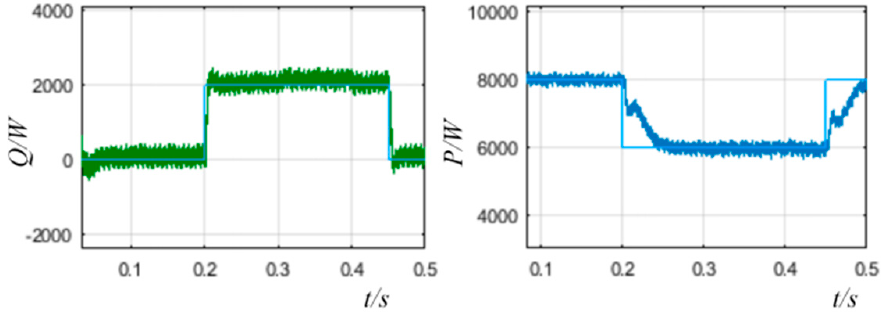
Figure 10. Active and reactive power under grid voltage frequency fluctuation with proposed control strategy.